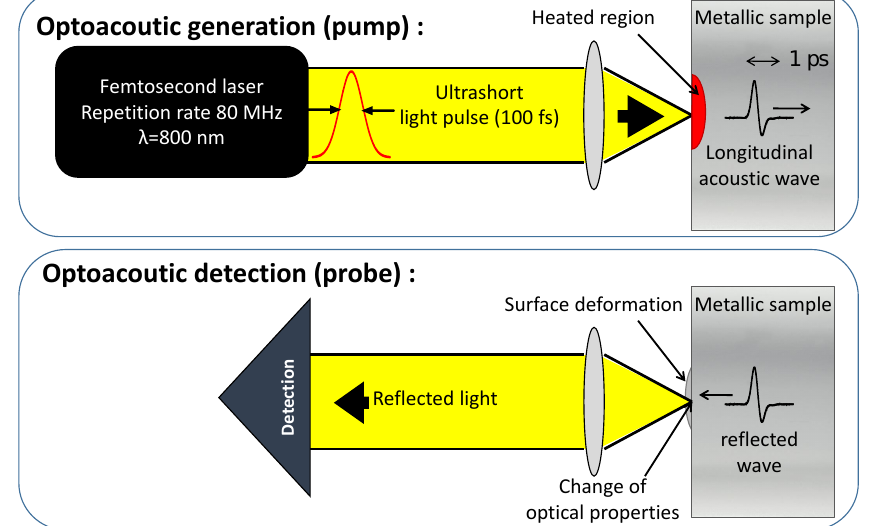
Figure 1. Femtosecond laser light pulse used here as a kind of ultimate “hammer” to generate an ultrashort (ps) acoustic strain. ( Top ) The pump is focused on one surface of the sample (focused spot of about 3 µ m) through a diamond window and absorbed on a length scale of ξ ( ≈ 10 nm). As soon as the pump laser pulse reaches the surface, it creates a sudden and small temperature increase ∆ T (less than 10 K). ( Bottom ) The change of temperature relaxes by launching an acoustic strain field (with frequency typically on the order of GHz in a metallic liquid) propagating at the sound velocity v l (the laser probe is here focused on the opposing face of the sample with respect to the pump